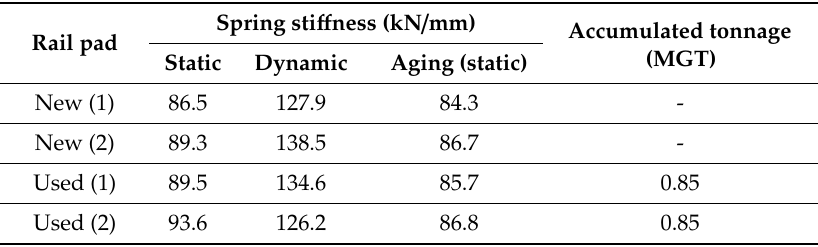
Table 5. Rail pad spring sti ff ness test